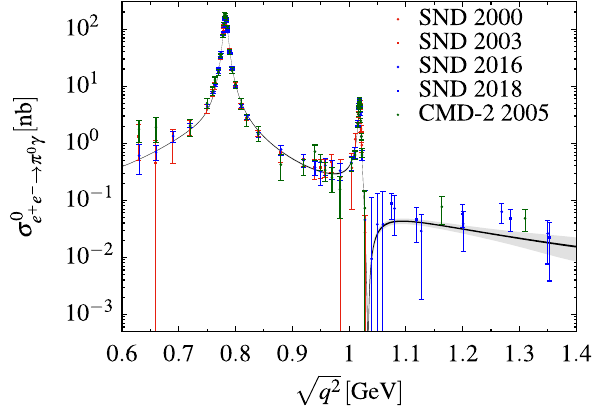
Fig. 1 The final fit to the e + e − → π 0 γ data sets as listed in Table 1 (with VP removed everywhere), where the gray band indicates the full uncertainty and the black band indicates the fit